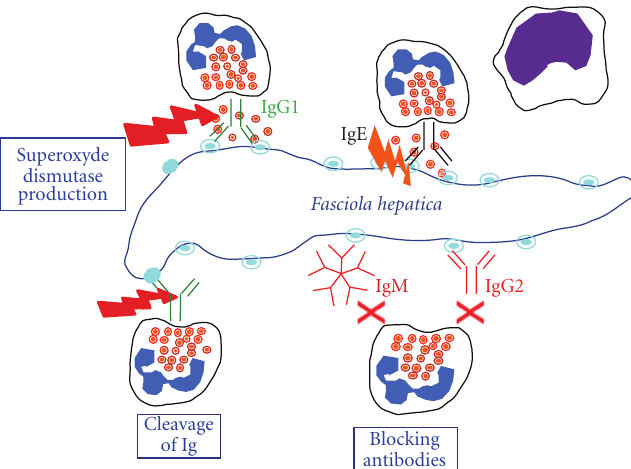
Figure 2: Main evasion mechanisms developed by Fasciola spp. against ADCC. Three main evasion mechanisms have been described: (i) production of superoxide dismutase and Glutathione S-transferase which neutralize superoxide radicals, (ii) cleavage of IgE and IgG involved in the ADCC, and (iii) production of blocking antibodies IgM and IgG2 which could inhibit eosinophil adhesion to flukes.